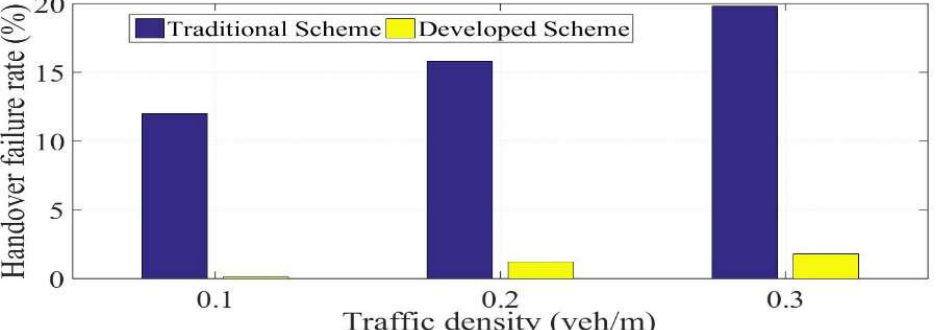
Figure 11. Handover failure rate of traditional handover schemes and the developed scheme at different traffic densities.